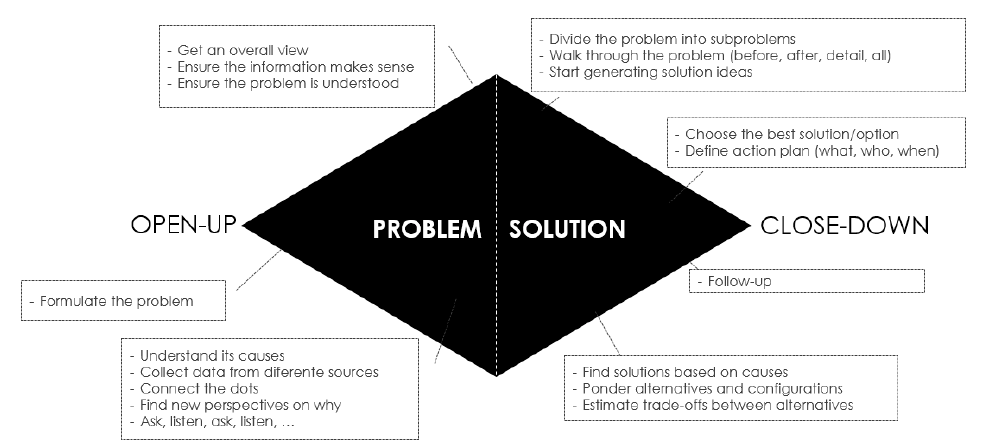
Figure 7. Workflow of the Problem Solving Process (authors).